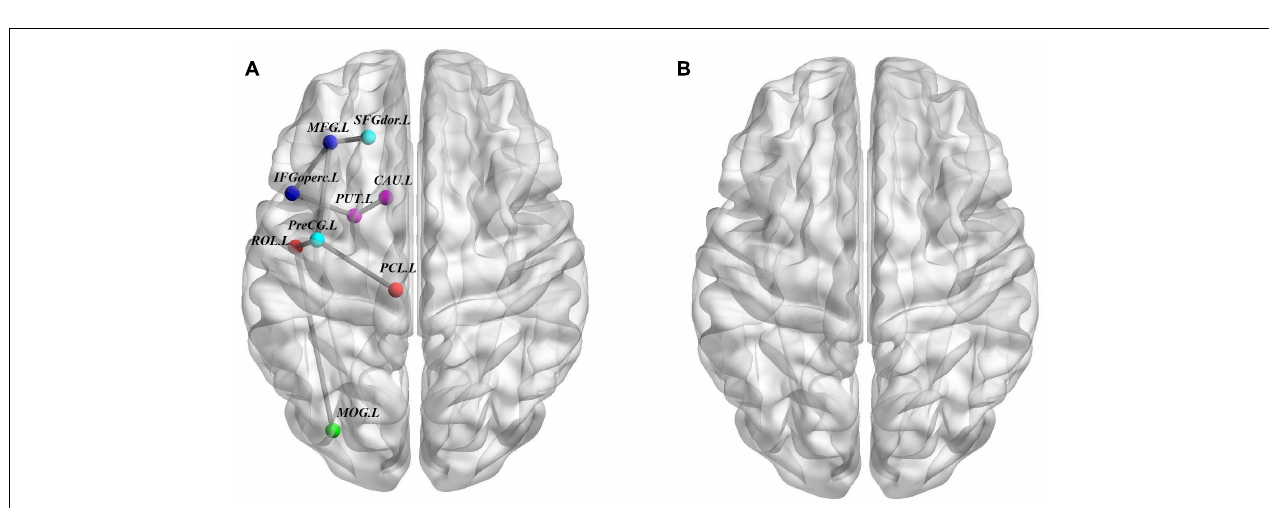
FIGURE 2 | Comparisons of hub distributions among the ASD, ADHD, and TD groups. (A) ASD hub distributions, (B) ADHD hub distributions, (C) TD hub distributions; for the definitions of the abbreviations, see Table 1 ; regions in the black circle including the MTG.L, STG.L, PoCG.L, and MFG.R were additional hubs of both the ASD and ADHD groups compared with the TD controls. In addition, the ACG.L in the black rectangle was identified as a hub in the ADHD and TD groups but not in the ASD group. The regions were mapped onto the cortical surfaces using BrainNet viewer software (www.nitrc.org/projects/bnv/). Note that the FN-weighted WM network for each participant was constructed using the AAL template.